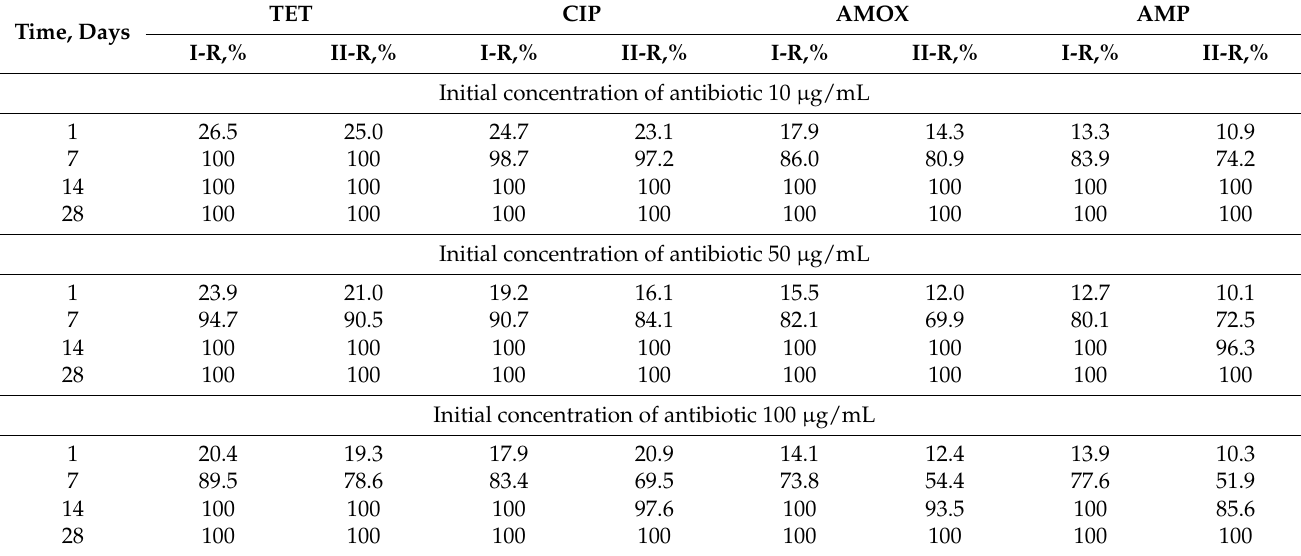
Table 2. Sorption efficiency during first (I) and second (II) cleaning cycle at pH